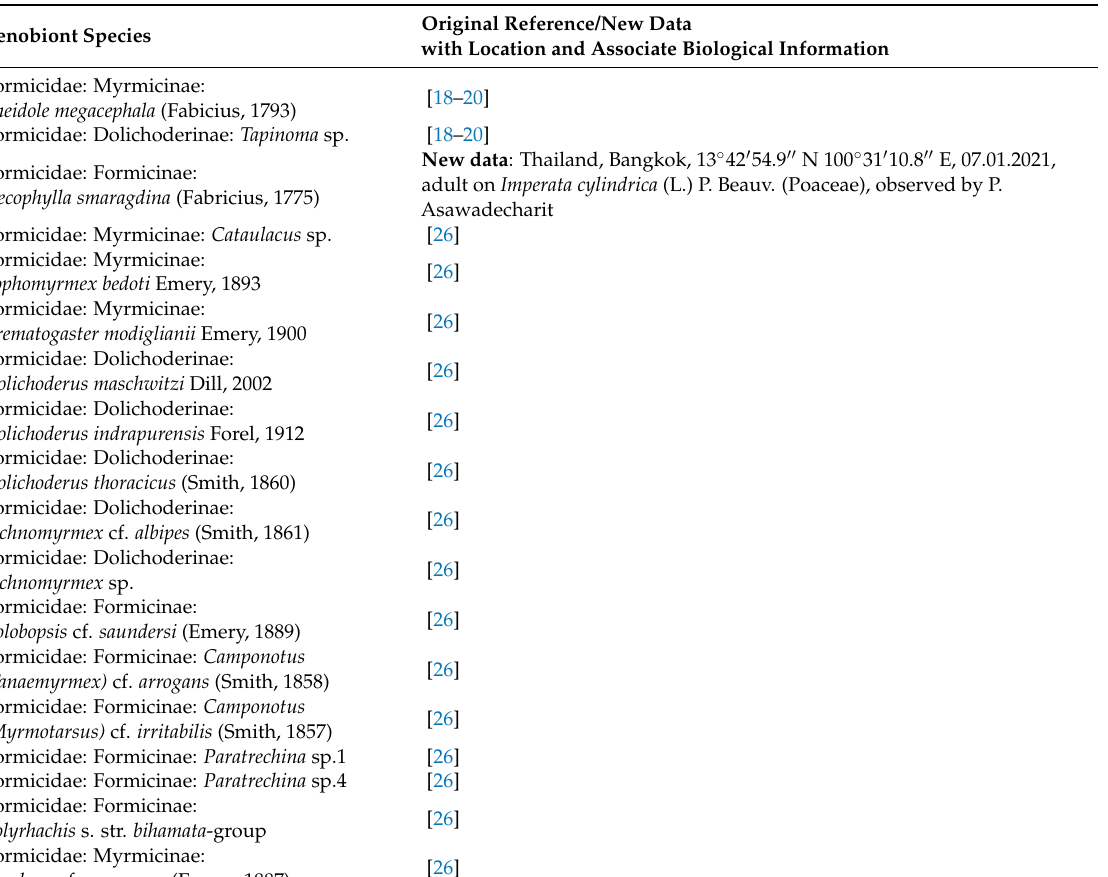
Figure 5b Tropidocephala sp. 3.9 Delphacidae indet. Formicidae: Myrmicinae: Cataulacus sp. Delphacidae